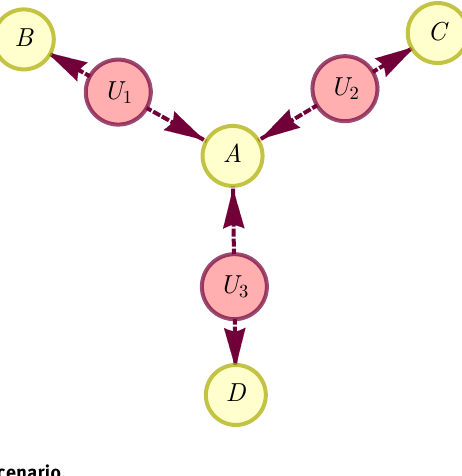
Figure 7: A star-shaped correlation scenario.